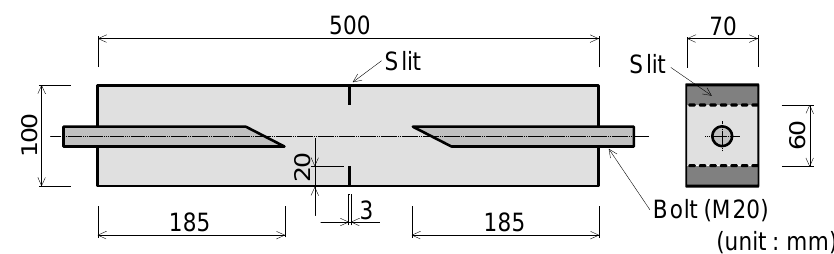
Figure 2. Dimensions of specimen for uniaxial tension test.